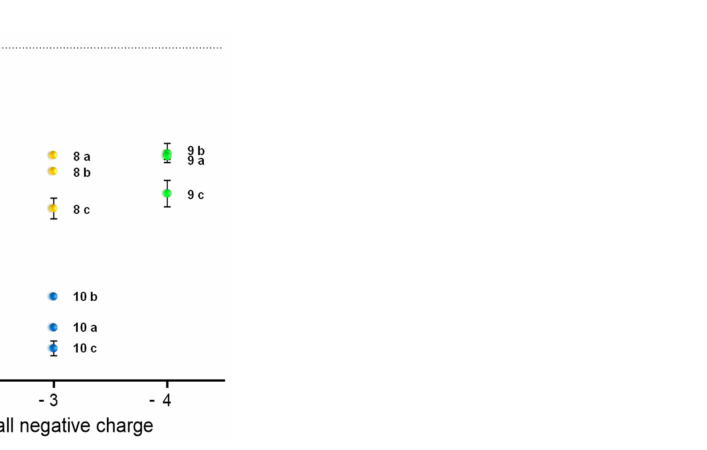
Figure 4. Plot of log D vs. overall negative charge of the radiolabeled MIU-peptide-bioconjugates [ 68 Ga]Ga- 7 a-c , [ 68 Ga]Ga- 8 a-c , [ 68 Ga]Ga- 9 a-c and [ 68 Ga]Ga- 10 a-c